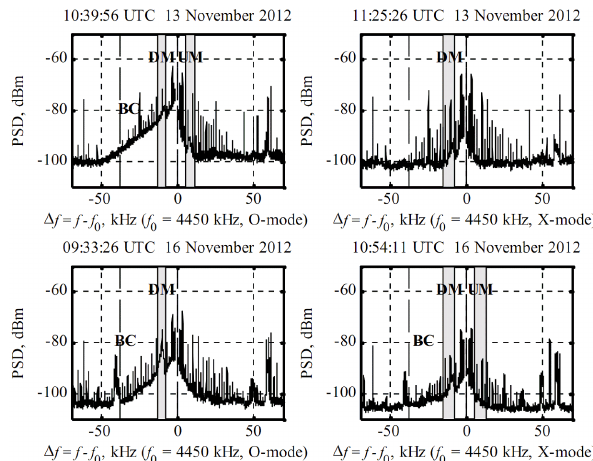
Figure 2. The power spectral densities (PSD) observed during the experiments.